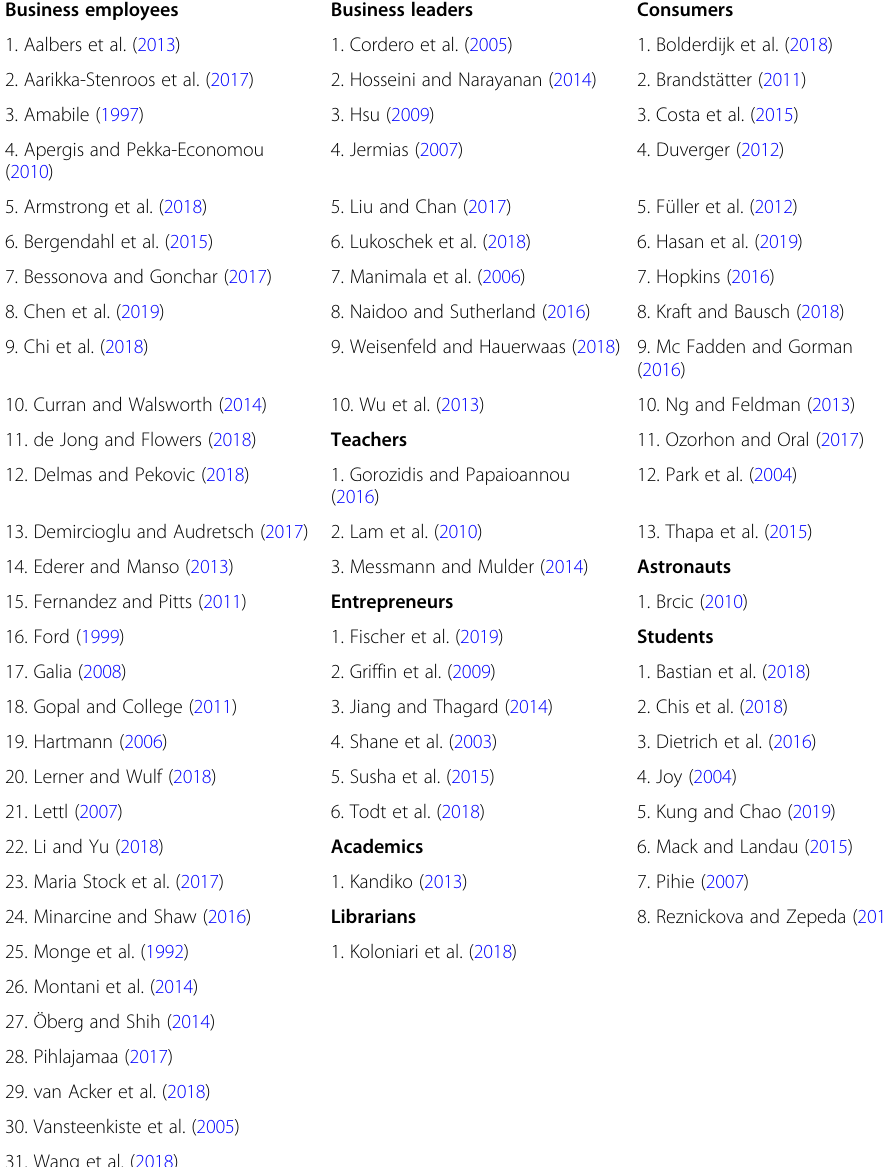
Table 2 Study participant groupings of included studies Business